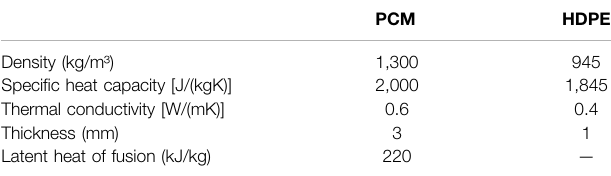
TABLE 1 | Properties of PCM and HDPE.